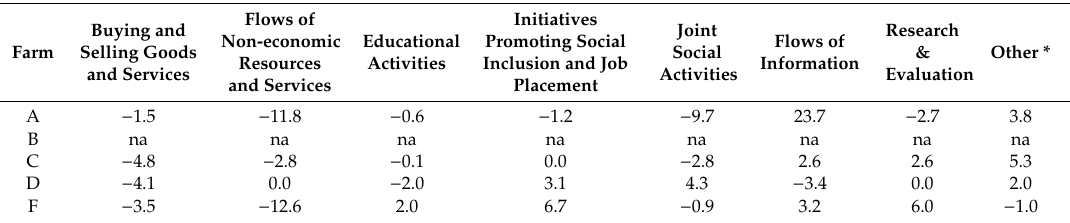
Table 9. Variation (expressed as percentage points) over time (T0 − T1) in the nature of the links made by the participants with the reported